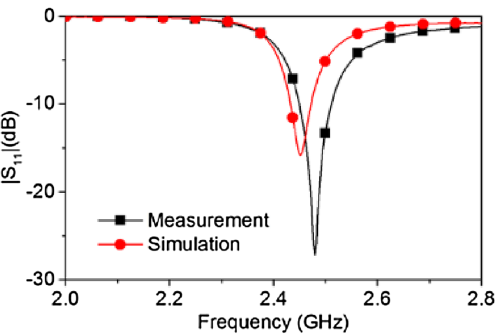
Figure 16. Simulated and measured |S 11 | of the open-ended quartz loaded waveguide.